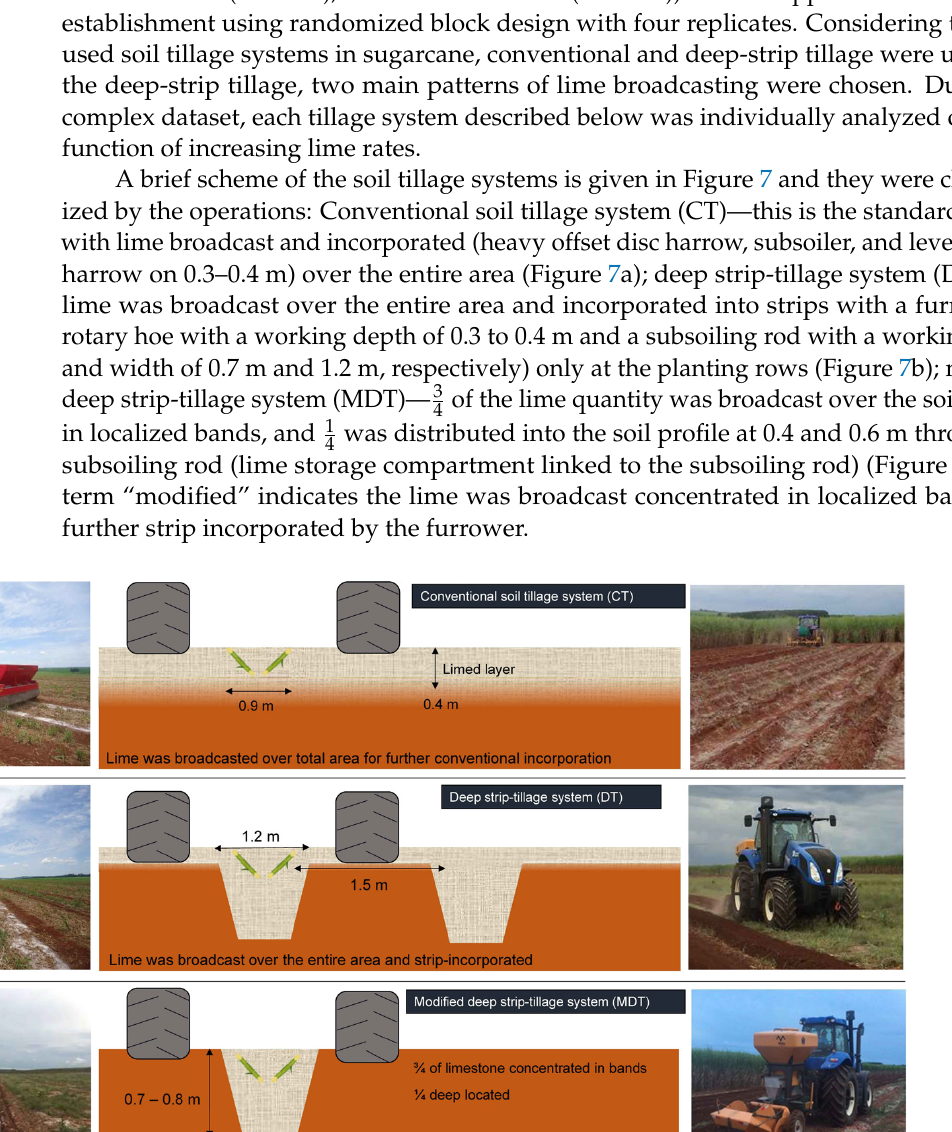
Table 2. Lime doses and forms of application under different soil tillage systems.